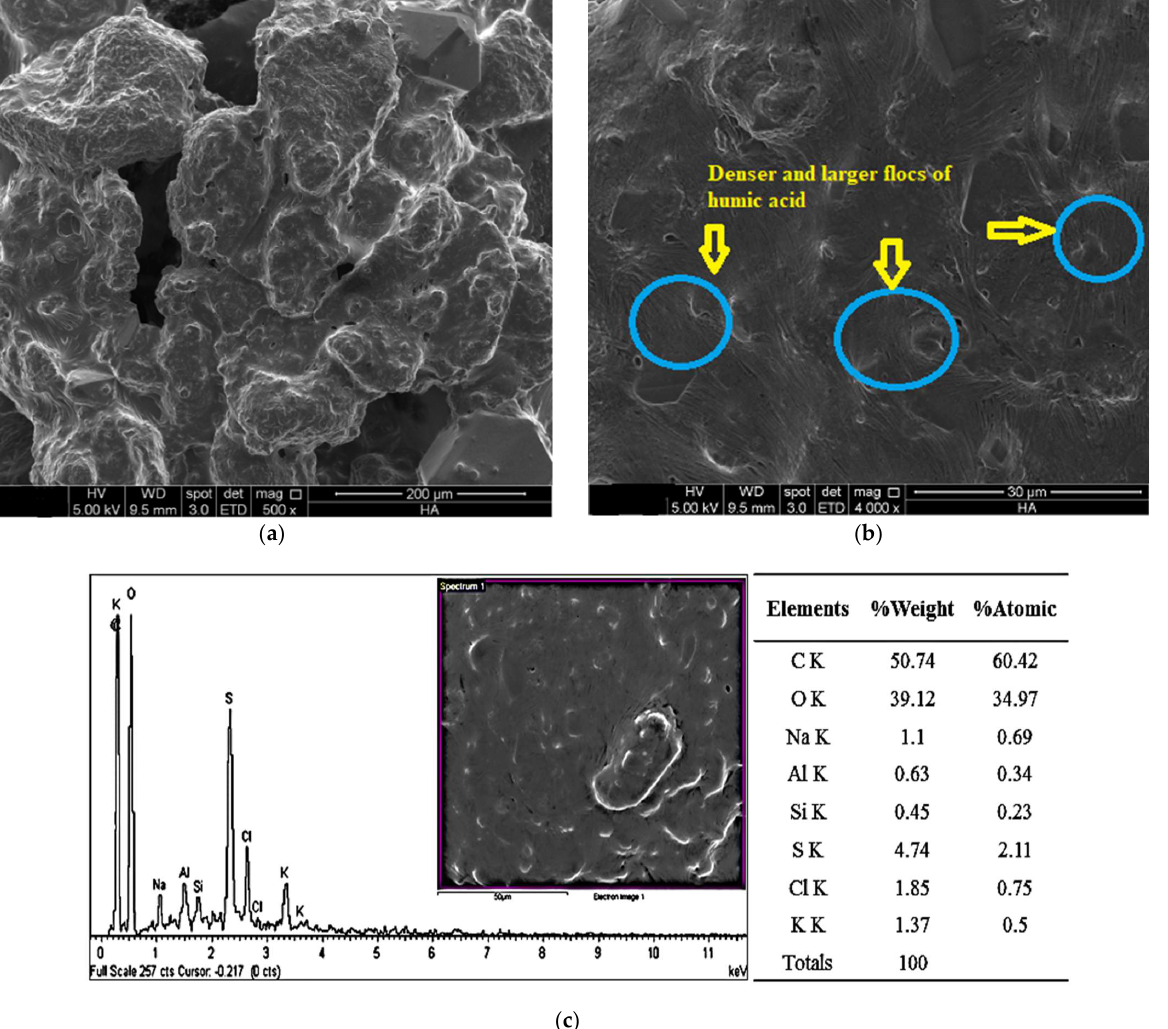
Figure 5. SEM/EDX of isolated humic acid ( a , b )—display the SEM images of PBLS humic acid at 1 K and 4 K magnification, ( c )—depicts the EDX analysis outcome).